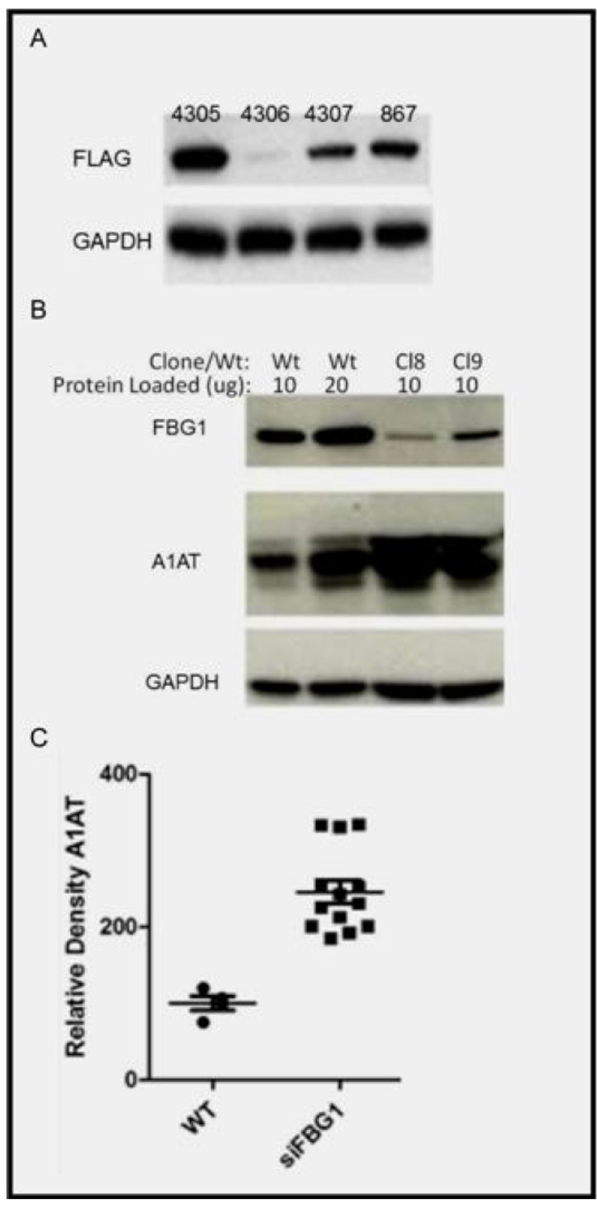
Fig 3. Knockdown of FBG1 in HepG2 cells increases levels of endogenous A1AT. A) Transient transfection of shRNAs against FBG1 in Cos-7 cells. B) Stable HepG2 clones were selected after infection with FBG1-knockdown lentivirus. Total cell lysates were separated on SDS-PAGE gels and probed with antibodies against FBG1, A1AT, and GAPDH (loading control) (n = 3). C) HepG2 knockdown (KD) cells contained 241 units of A1AT while WT HepG2 cells had 100 units of A1AT. Densitometry of A1AT in “ A ” , values were compared to the value obtained from 10 μ g of WT HepG2 cells, normalized to loading control GAPDH (Fig 3A, lower